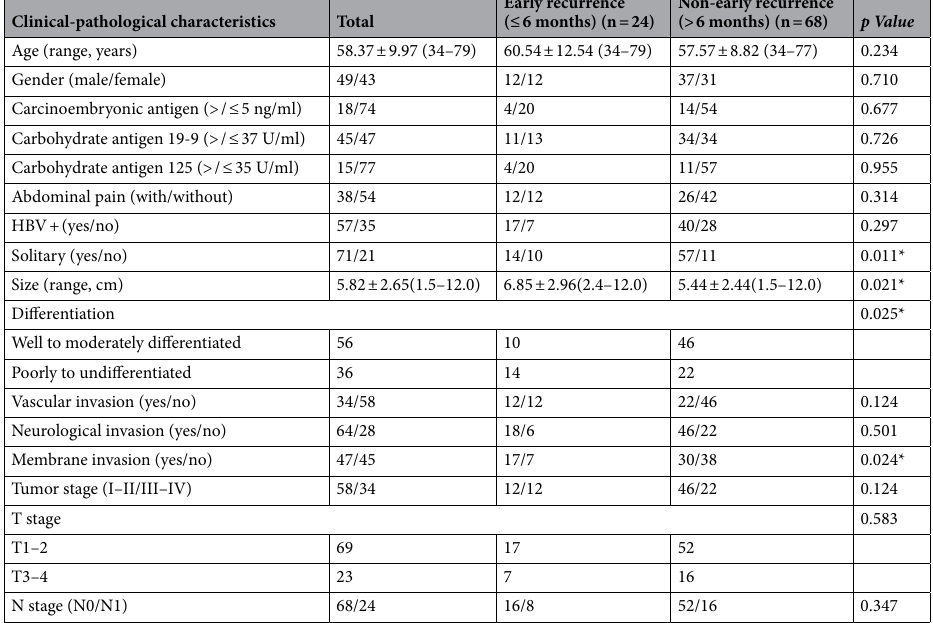
Table 1. Comparison of clinicopathological characteristics of patients with IMCC with early recurrence and non-early recurrence in training set. TNM stage according to Japanese TNM stage of intrahepatic cholangiocarcinoma. * p < 0.05.